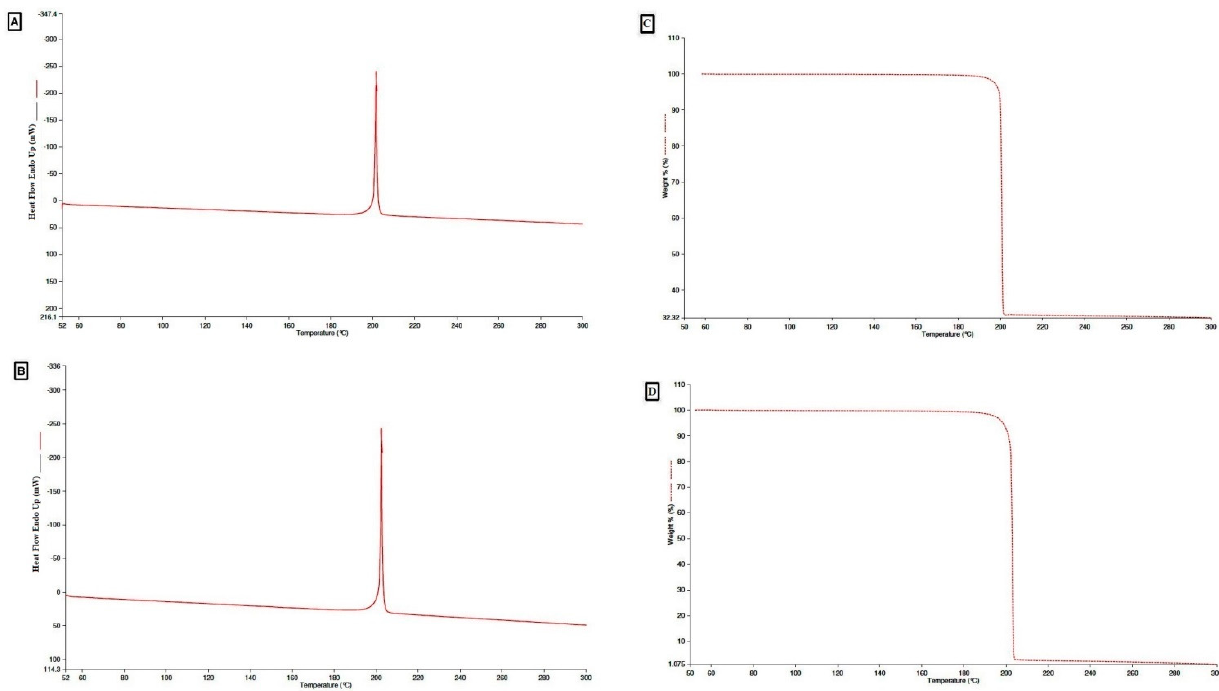
Figure 2. DSC curve of ( A ) TMZ, ( B ) TMZ equilibrated sample retrieved from H 2 O and TGA curve of ( C ) TMZ, ( D ) TMZ equilibrated sample retrieved from H 2 O.